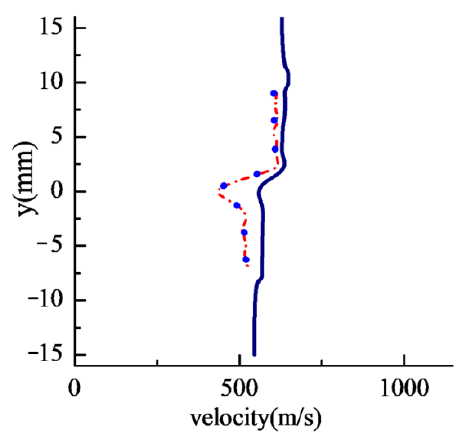
Figure 13. Velocity profiles of the simulation and FLEET at x = 100 mm in the test section (simulation, solid line; FLEET, red dash-dot, 5 us delay and blue dot, 10 us delay).